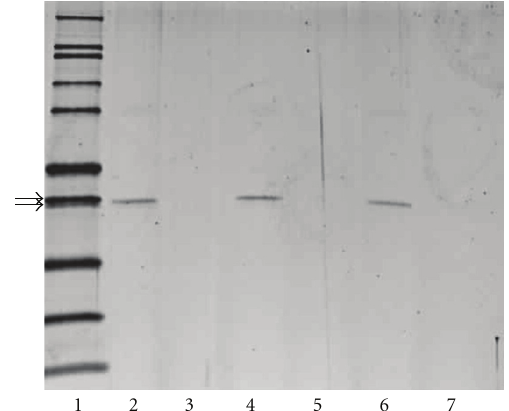
Figure 2: SDS-PAGE analysis of SEB treated with chlorine. Lane 1: molecular mass standards (in kilodaltons); lane 2: untreated control SEB after 1min; lane 3: chlorine-treated SEB after 1min; lane 4: untreated control SEB after 1 hour; lane 5: chlorine-treated SEB after 1 hour; lane 6: untreated control SEB after 24 hours; lane 7: chlorine-treated SEB after 24 hours. Arrows indicate 31 kDa molecular weight marker (top arrow) and 28kDa SEB (bottom